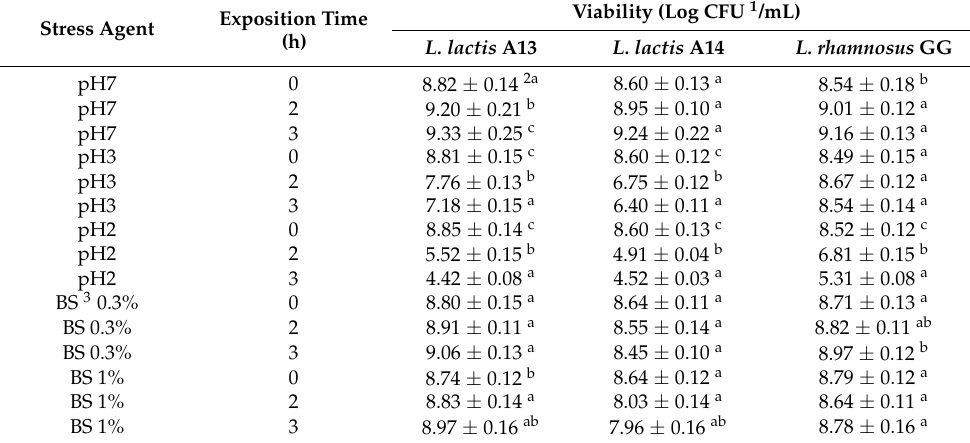
Table 4. Viability of the Lactococcus lactis after exposure to low pH and bile salt. Stress